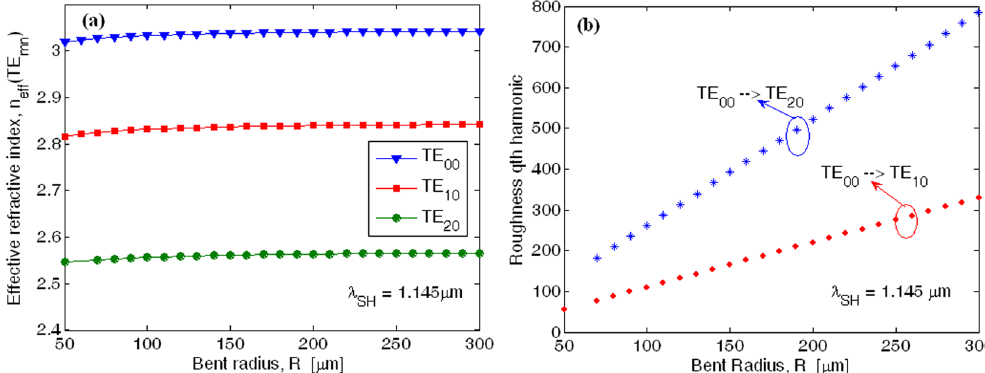
Figure 5. ( a ) Effective refractive index as a function of the bent radius for the fundamental and higher order quasi-TE modes at